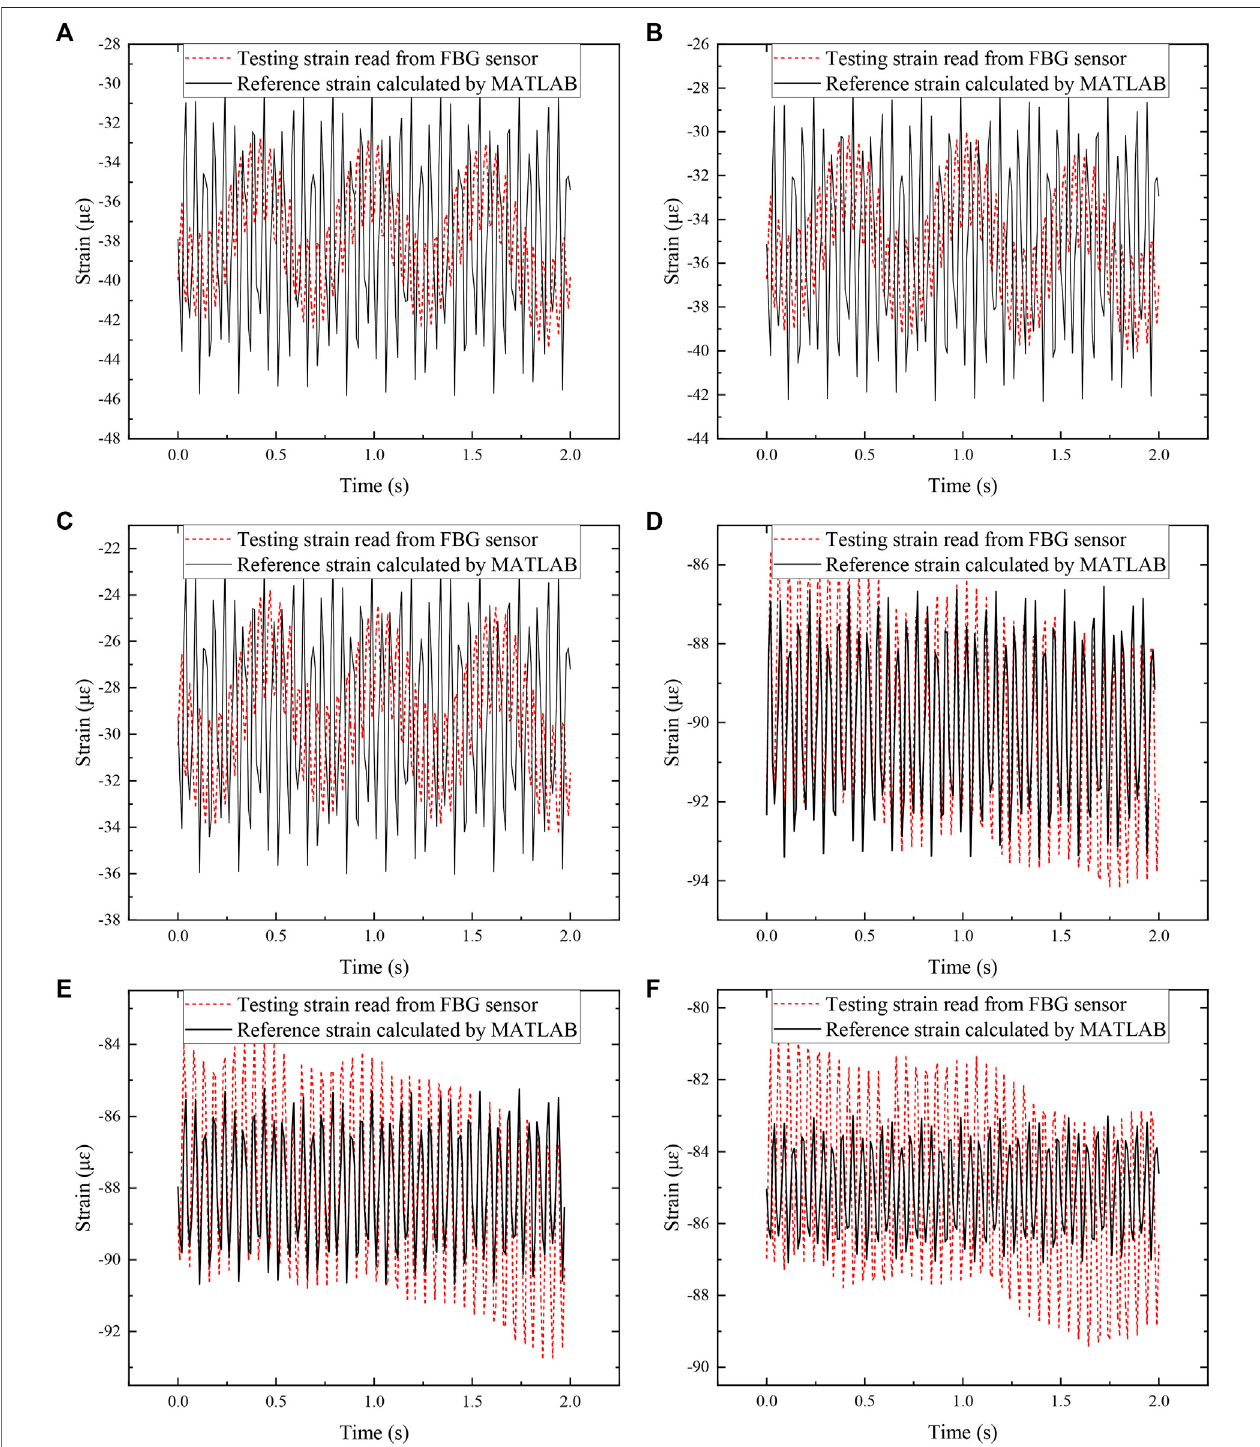
FIGURE14| Comparisonoftheoreticalstrainand measured strainin20 Hz: (A) Bare-FBG2-pipe3; (B) Bare-FBG3-pipe3; (C) Bare-FBG4-pipe3; (D) Bare-FBG5- pipe3; (E) Bare-FBG6-pipe3; (F) Bare-FBG7-pipe3.